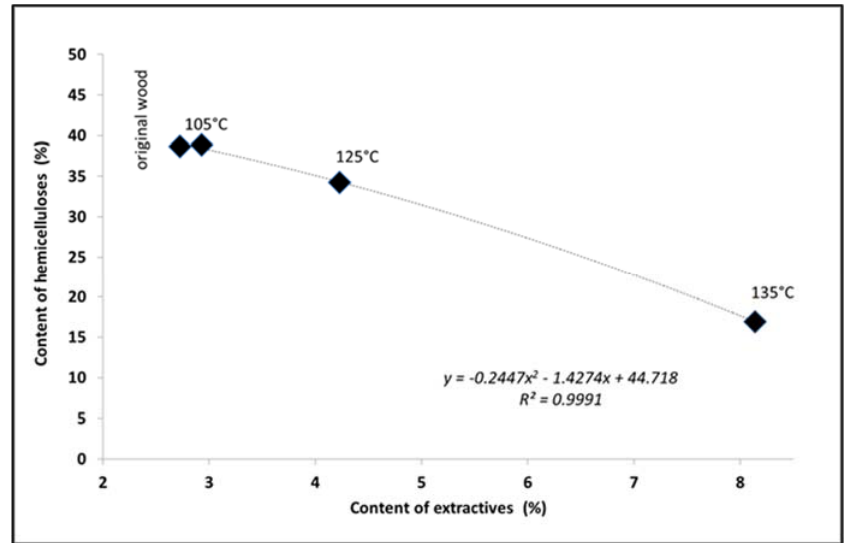
Figure 3. Dependence of the contents of hemicelluloses and extractives.